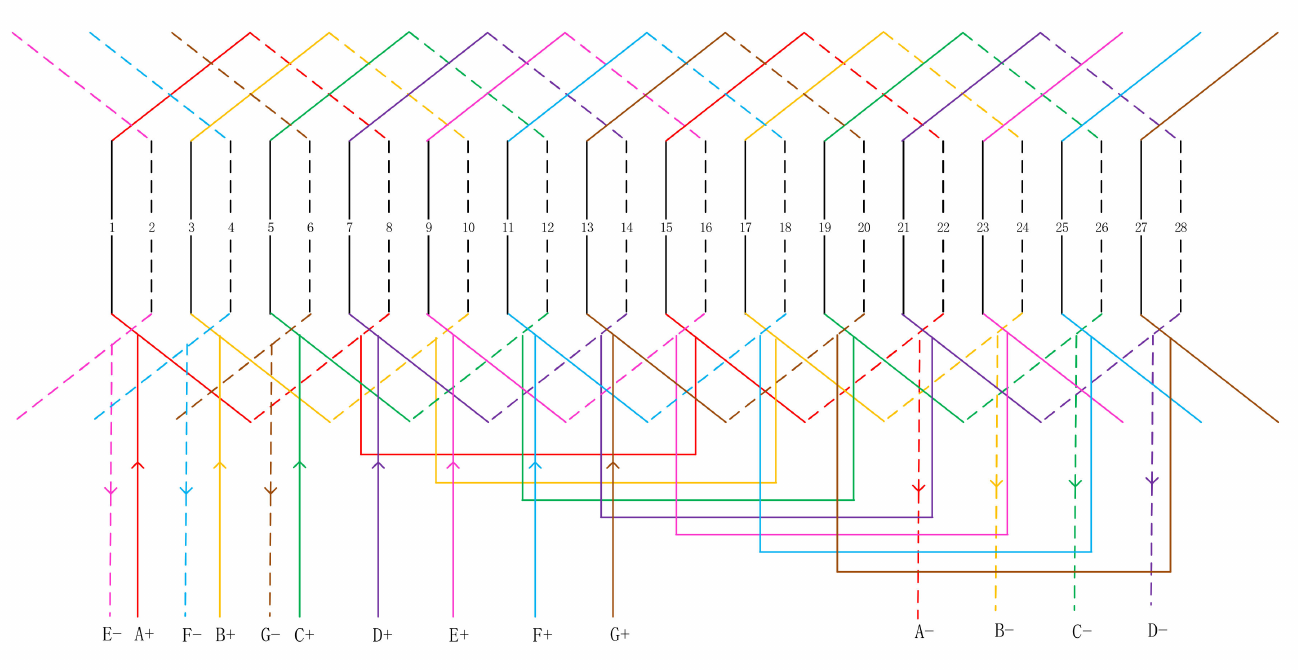
Figure 12. The winding distributions of the seven-phase